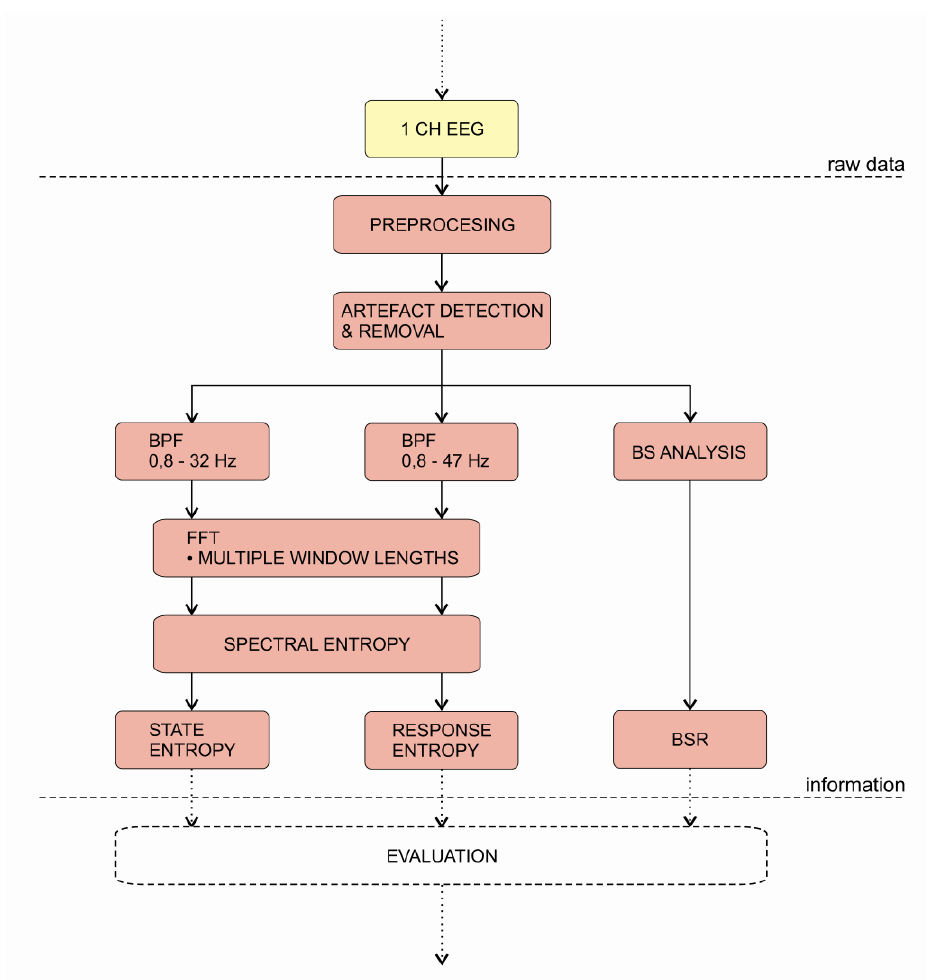
Figure 11. Block diagram of the Entropy module algorithm. Abbreviations: BS (burst suppression), BPF (band pass filter), BSR (burst suppression ratio), FFT (fast Fourier